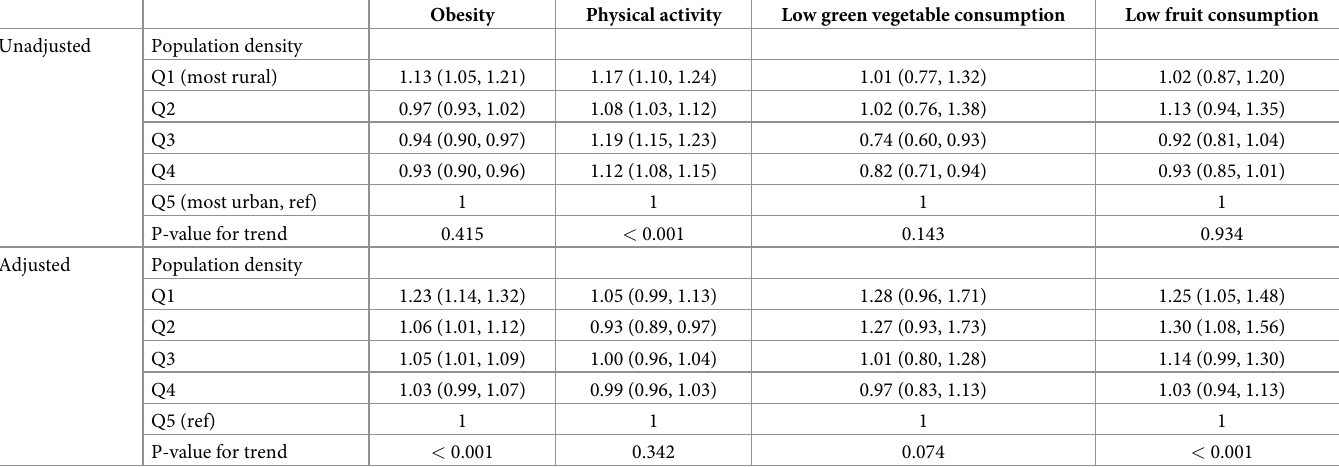
Table 3. Model estimates of obesity, physical activity, and fruit and vegetable consumption based on population density quintile. Obesity